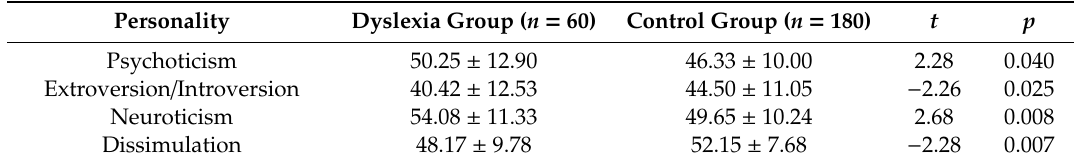
Table 3. Scores of Eysenck Personality Questionnaires between the two groups (Mean ± SD).